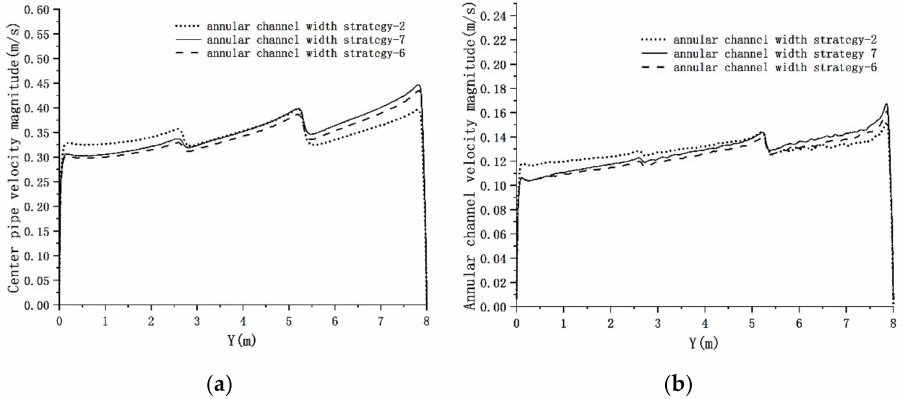
Figure 14. Radial velocity changes at different locations: ( a ) Radial velocity changes at the center pipe; ( b ) Radial velocity changes at the annular